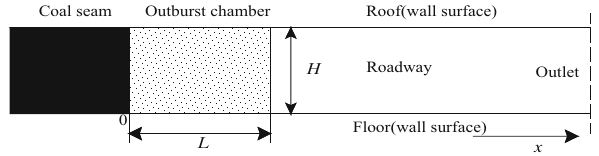
Fig. 1 Schematic model of outburst